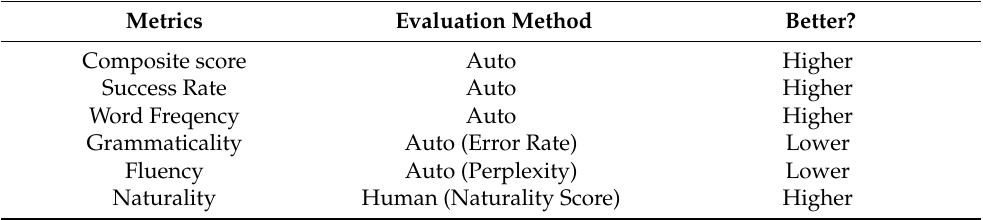
Figure 5. BiLSTM framework. Table 1. Details of evaluation metrics. “Auto” and “Human” represent automatic and human evaluations respectively. “Higher” and “Lower” mean the higher/lower the metric, the better a model